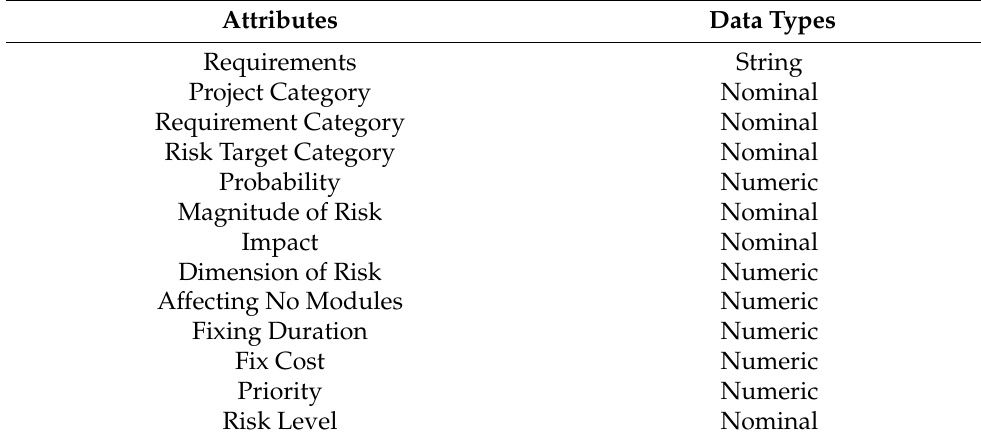
Table 4. Risk dataset